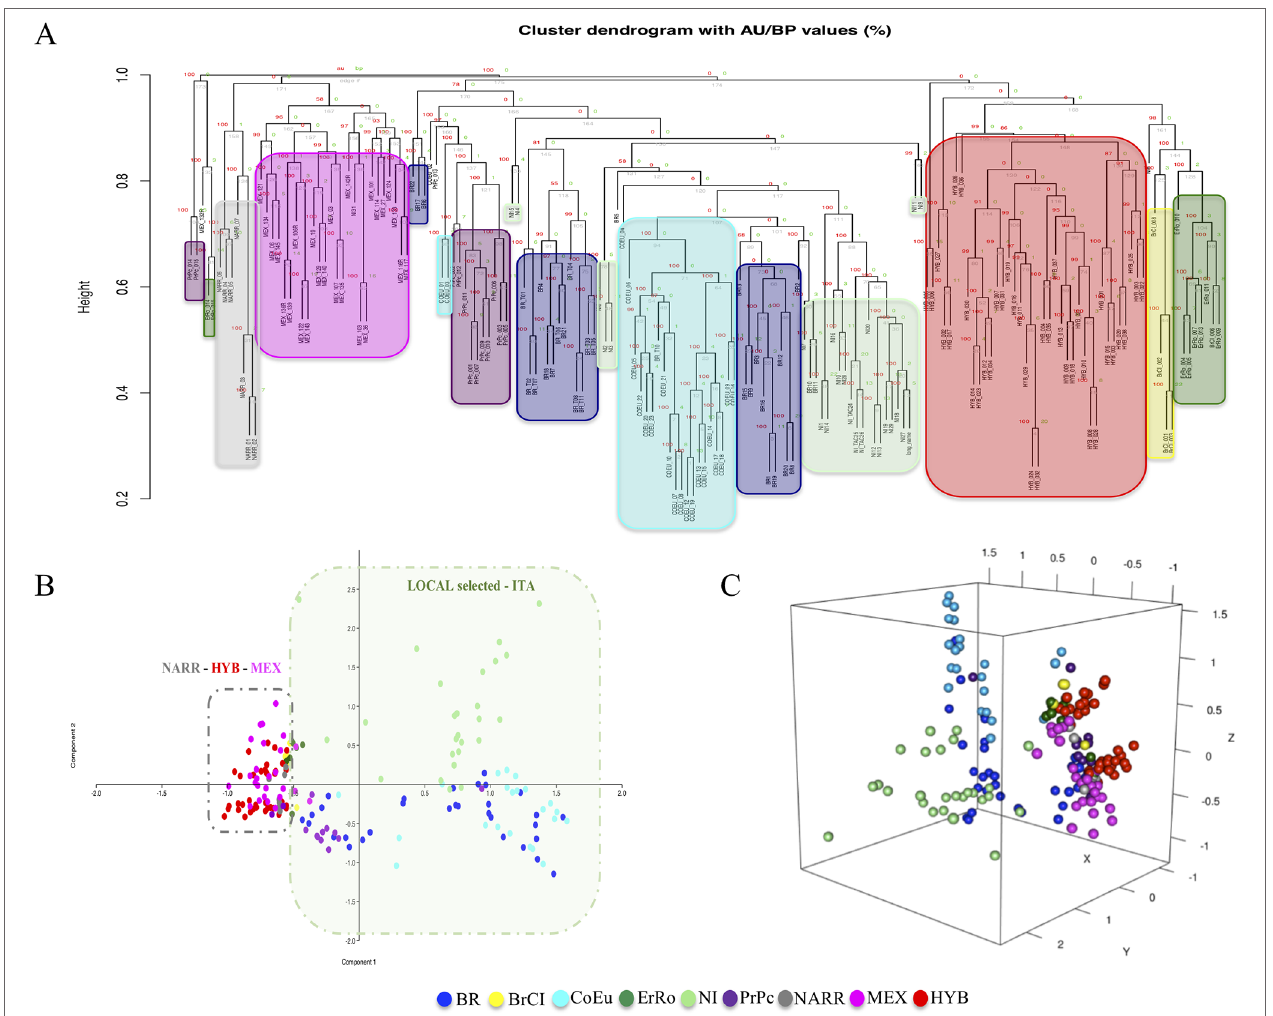
FIGURe 3 | Hierarchical clustering and PCAs based on CNVRs (CNV encoded as in matrix_1). Panels (A) , (B) , and (C) are the dendrogram, the PCA-2D, and the PCA-3D, respectively.